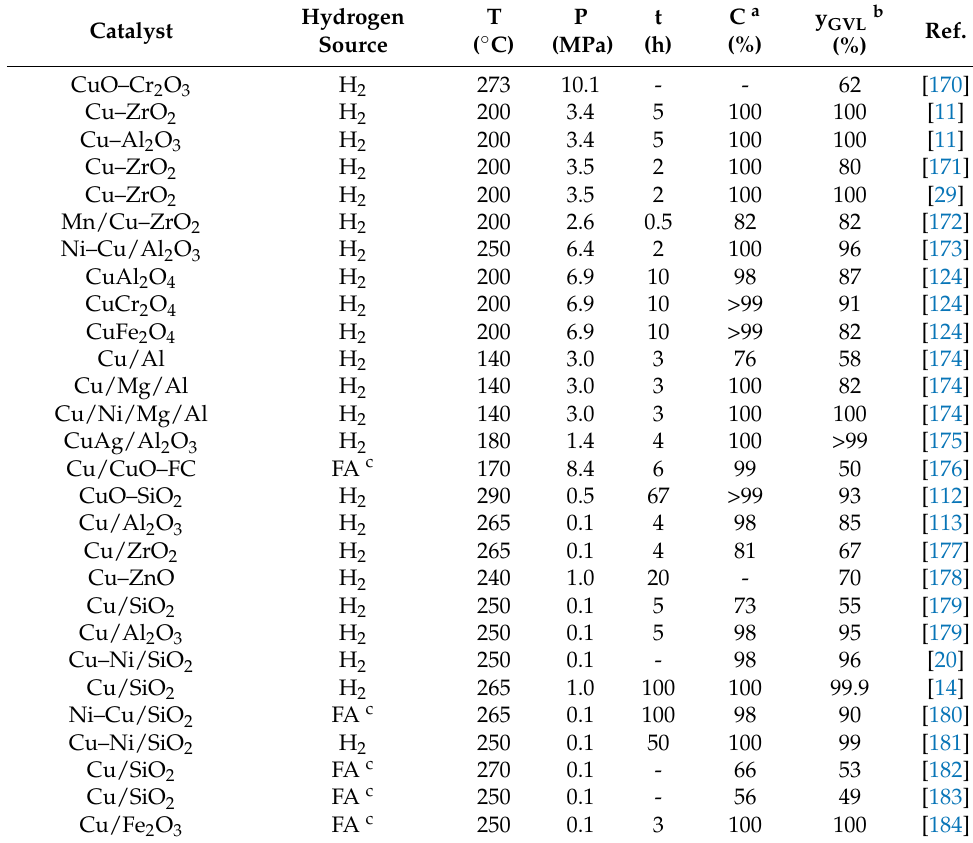
Table 4. Catalytic activity of Cu ‐ based catalysts for hydrogenation of LA to GVL.